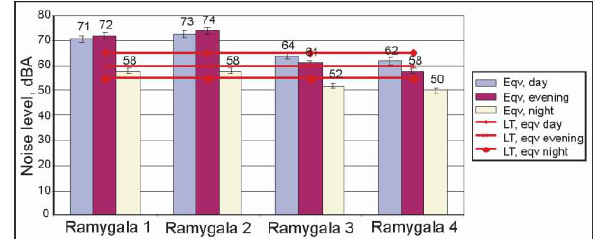
Fig. 6. Dynamics of equivalent noise levels in Ramygala street within twenty four hours